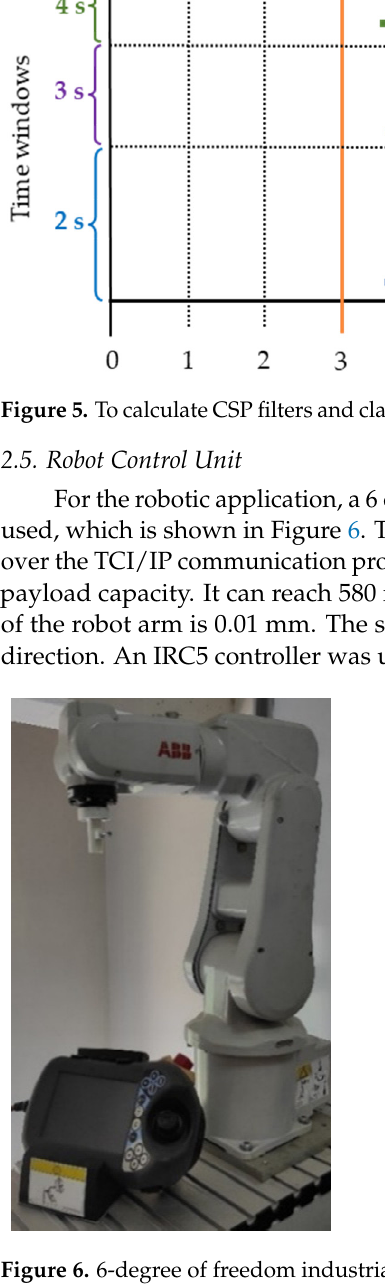
( d ) Figure 7. ( a ) Home position of the robot arm, ( b ) forward movement, ( c ) left movement, ( d ) right movement. 3. Results After finishing the recording for all subjects, we continued off-line testing the influ- ence of different variance time windows on the classification result. We repeated the CSP and classifier generation presented in section off-line data processing for each of the 1, 1.5, and 2 s variance time windows. Then, we generated the results offline by applying the created spatial filters and classifiers on the last two runs of data from each subject. To